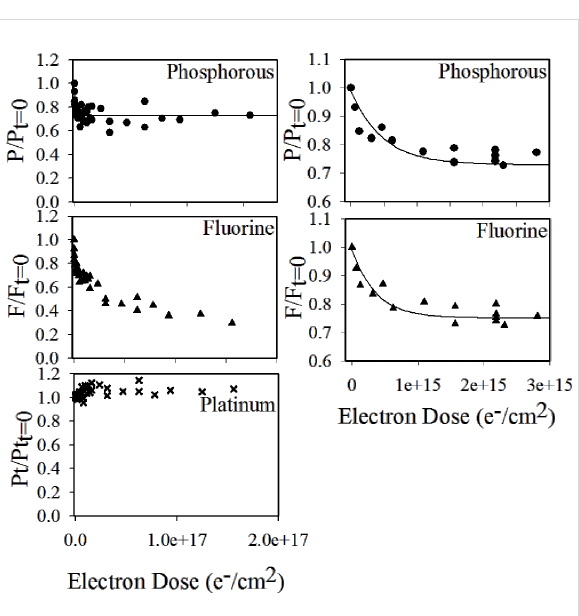
Figure 16: Electron dose dependence of the fractional coverage of Phosphorous (P/P D=0 ), Fluorine (F/F D=0 ) and Platinum (Pt/Pt D=0 ). The left-hand side plots show the changes in fractional coverage for the full range of electron doses up to 2 × 10 17 e − /cm 2 . The right-hand side plots show the phosphorous and fluorine fractional coverage for the initial period of electron exposure up to 2 × 10 15 e − /cm 2 . Solid lines in the plot show a fit to experimental values based on the first order loss process. Reproduced with permission from [23], Copyright (2011) American Chemical